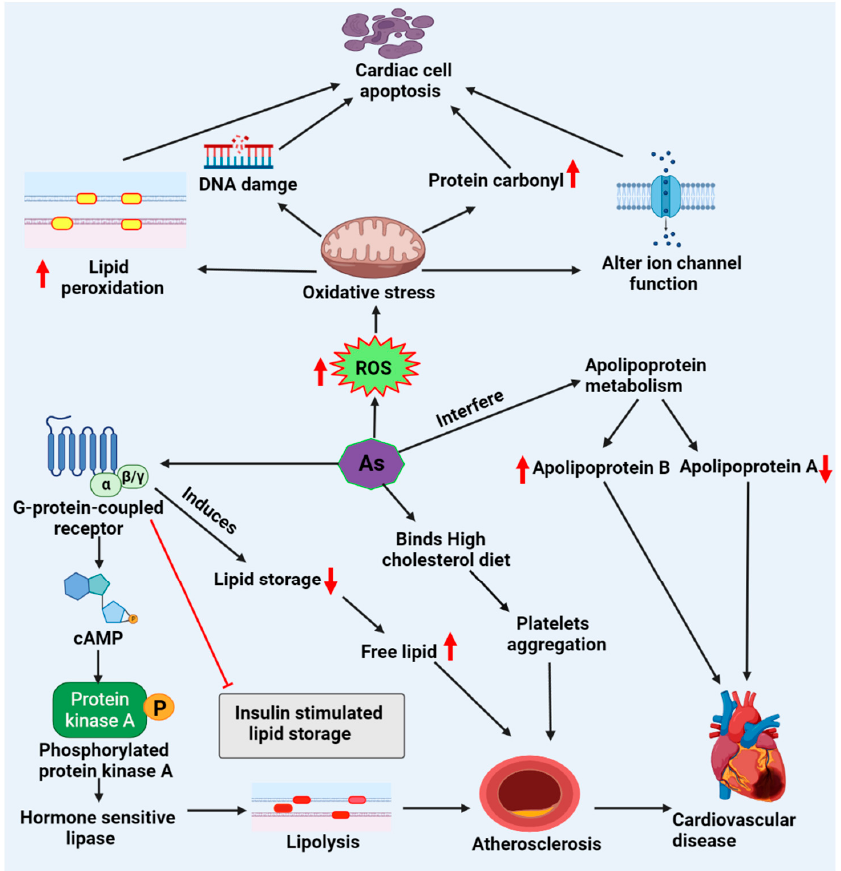
Figure 2. Arsenic-induced lipid deregulation and cardiotoxicity. Arsenic generates ROS, resulting in oxidative stress, which causes DNA damage, alters ion channel function, and increases lipid pe- roxidation, disturbing the mitochondrial process in cardiac cell apoptosis and cardiotoxicity. More- over, arsenic activates the process of lipolysis via G-protein-coupled receptors by activating hor- mone-sensitive lipase, decreasing lipid storage, and increasing free lipid, further promoting ather- osclerosis and cardiovascular diseases. Abbreviations: cAMP, cyclic adenosine monophosphate; ROS, reactive oxygen species.